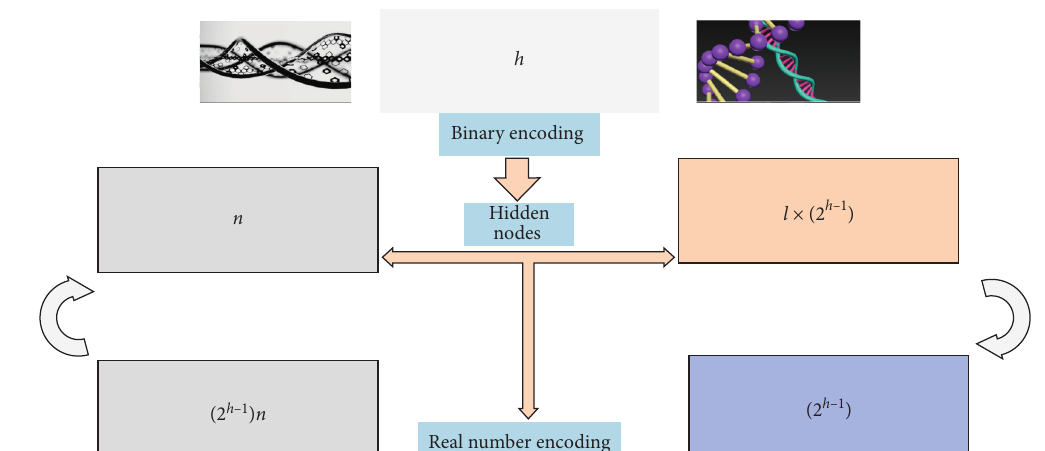
Figure 1: Components of corporate marketing.